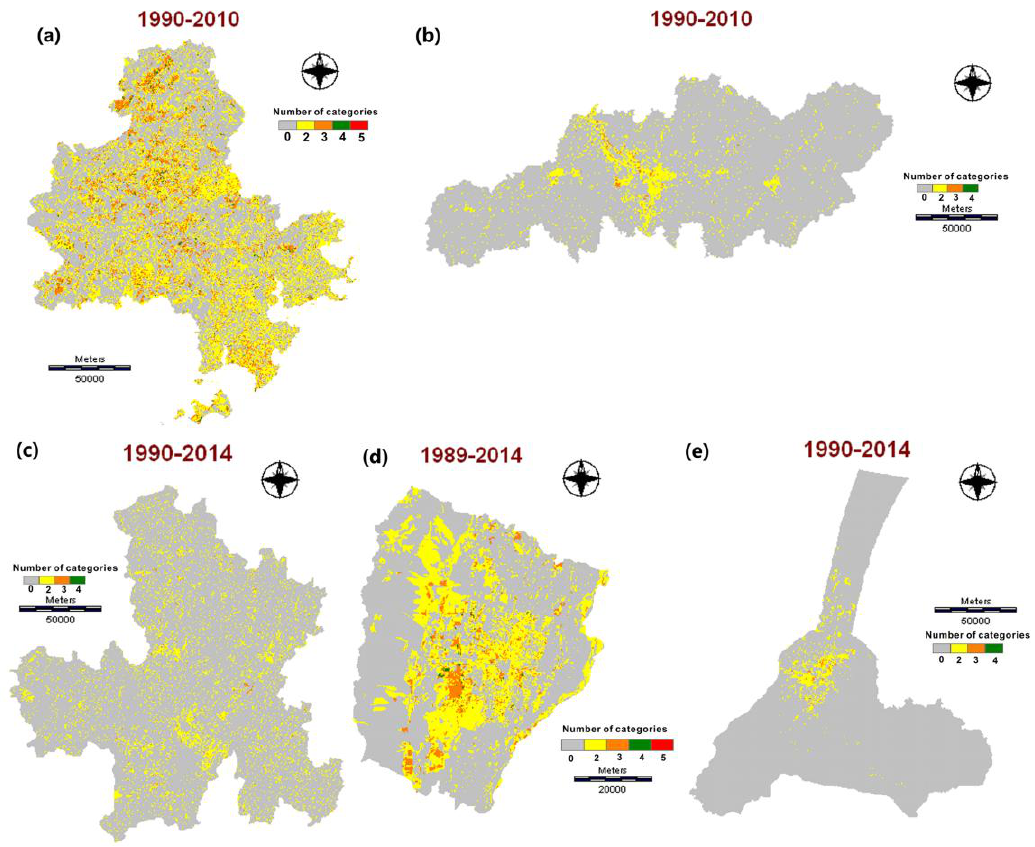
Figure. 7 The States map in the typical cities. Figure.8 compares the regional differences and